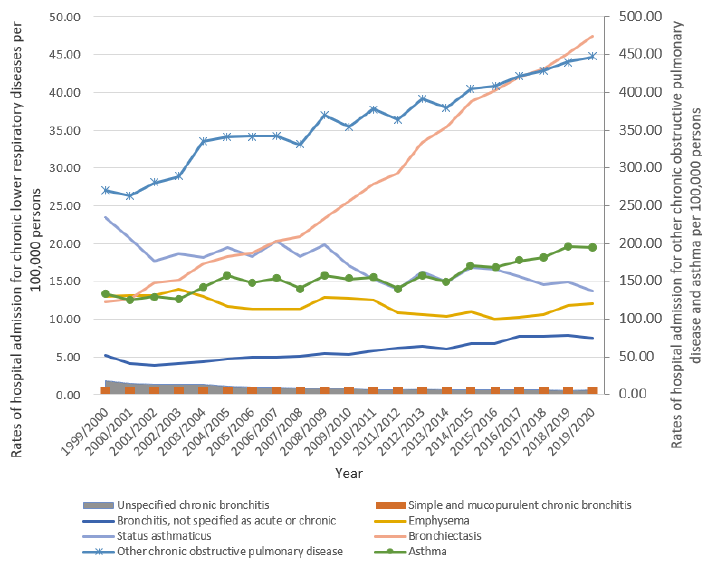
Figure 1. Rates of hospital admission for chronic lower respiratory diseases in England and Wales stratified by type between 1999 and 2020.